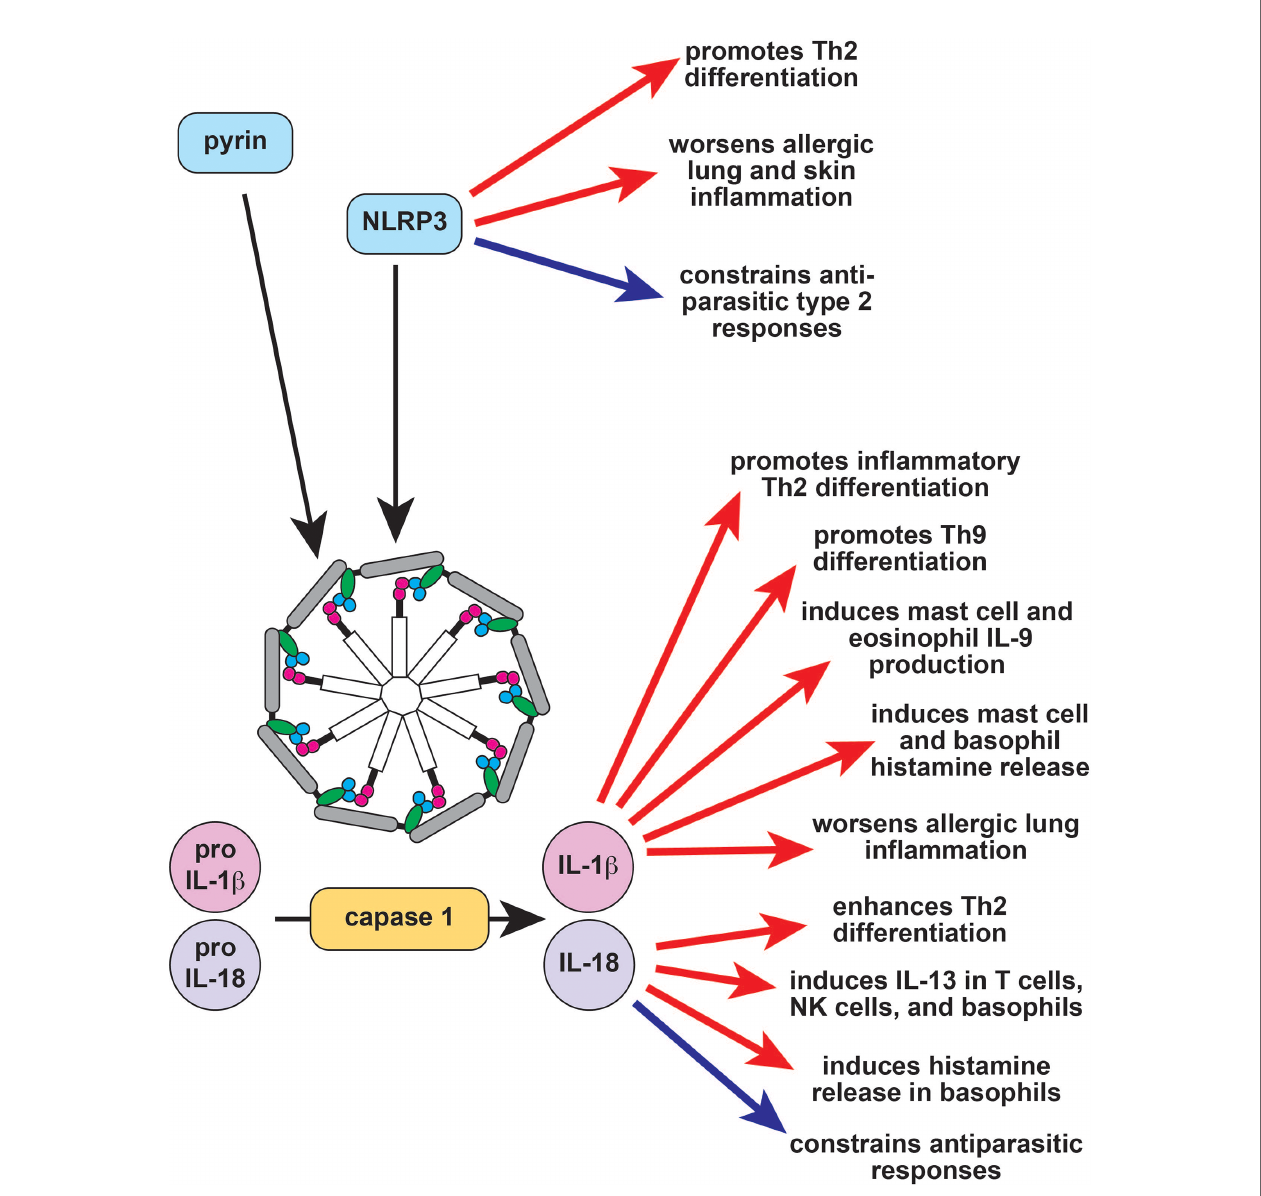
FIGURE 1 | The role of the in fl ammasome in type 2 immune responses. In fl ammasomes are large multimeric signaling molecules that process inactive pro-IL-1 b and pro-IL-18 into their active forms. Constitutive activation of the pyrin in fl ammasome results in Familial Mediterranean Fever (FMF), while activation of NLRP3 causes the autoin fl ammatory disease cryopyrin-associated periodic fever syndrome (CAPS). NLRP3 induces Th2 differentiation through in fl ammasome- dependent and independent mechanisms (red arrows) but also acts as a brake on type 2 responses to parasites (blue arrow). IL-1b enhances allergic responses through a variety of effector cells (red arrows), while the effect of IL-18 is context-dependent (red and blue arrows). Th2, T helper 2; IL-9, interleukin 9; IL-13, interleukin 13; NK, natural